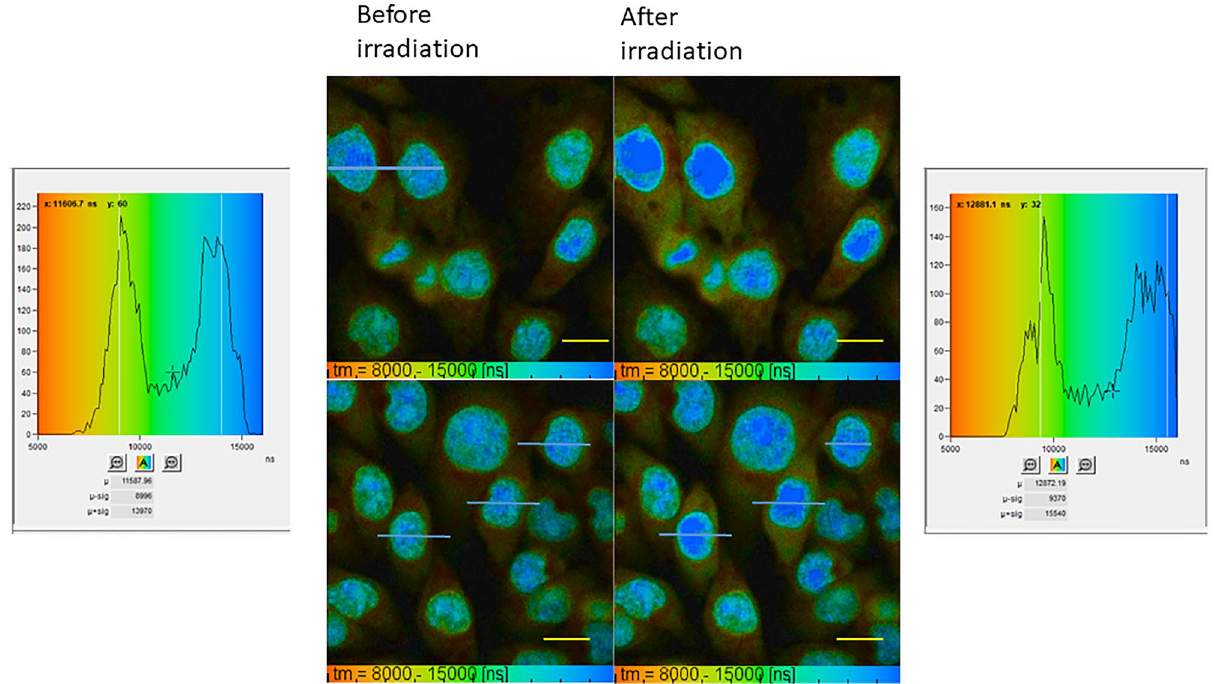
Figure 7. Viscosity changes in CHO cells labelled with Pt[L]Cl. PLIM map of cells before 405 nm laser irradiation (i and ii). PLIM after microwatts irradiation (ii and iv). Blue lines indicate irradiated cells to guide the eye. Scale bar 10